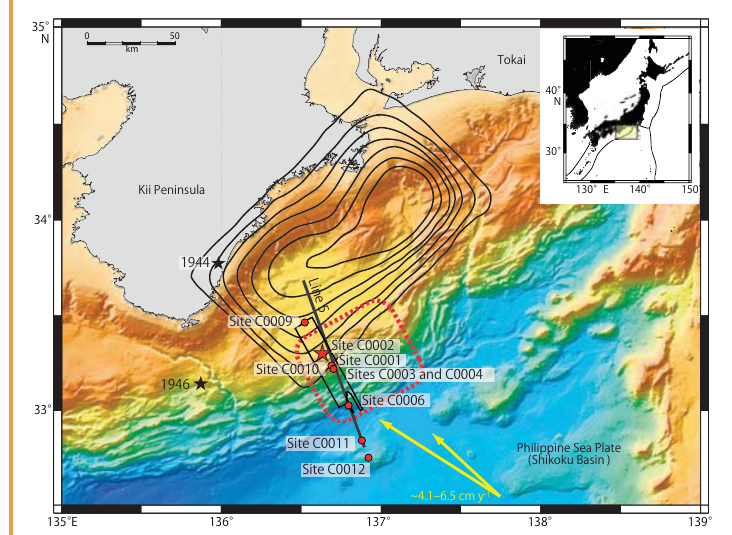
Figure 1. Map of Nankai accretionary complex off Kumano, showing NanTroSEIZE drill sites. Yellow arrows=computed far-field convergence vectors between the Philippine Sea Plate and Japan (Seno et al., 1993; Heki, 2007). Contours indicate estimated slip during the 1944 event (0.5-m intervals). Red box outlines region of recorded very low frequency events (Obara and Ito, 2005). Red circles=NanTroSEIZE drill sites. C0002 is marked with a red